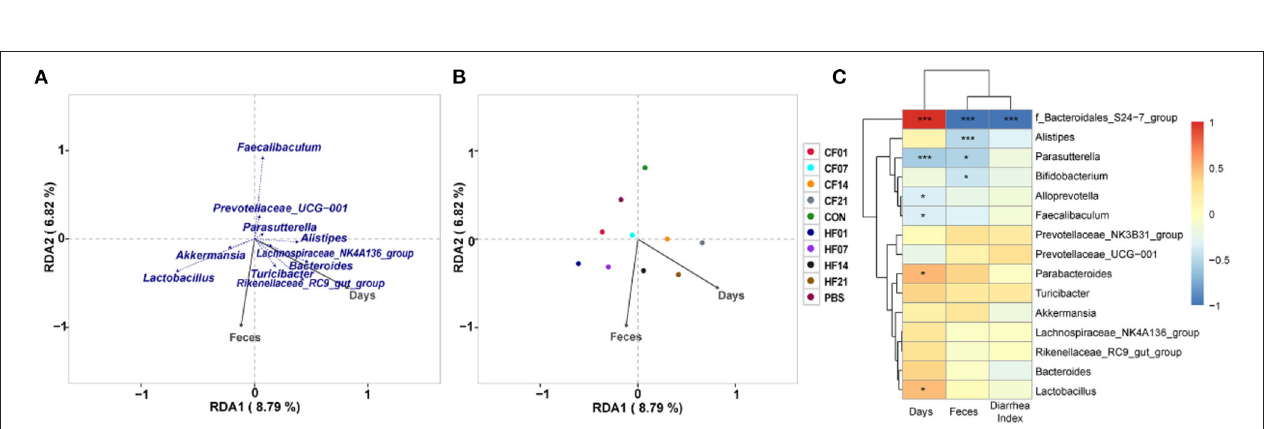
FIGURE 10 | Correlation analysis of environmental factors on microbial species composition in mice. (A) RDA (Redundancy analysis) / CCA (Canonical Correspondence analysis) analysis; (B) Distance-based redundancy analysis; (C) Relevance heatmap. * P < 0.05, *** P < 0.001 compared with each group.